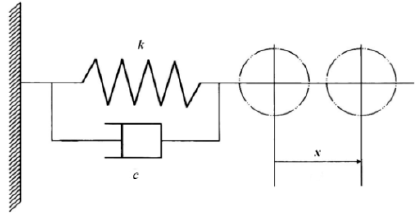
Figure 1. Spring damper